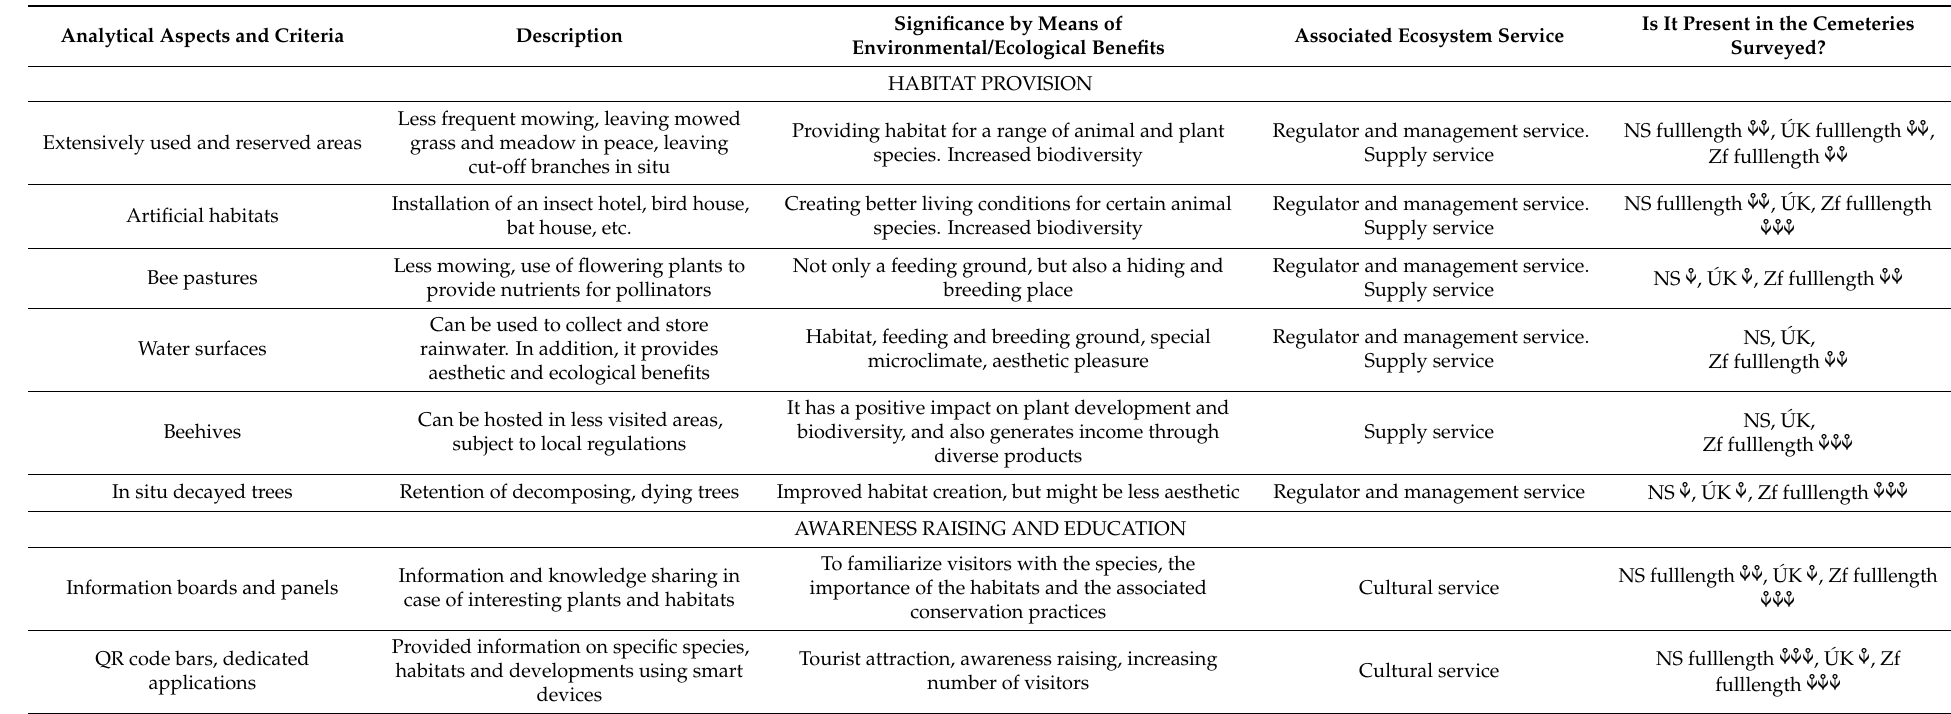
Table 2. Environmental (habitat) values of cemeteries (authors’ table).